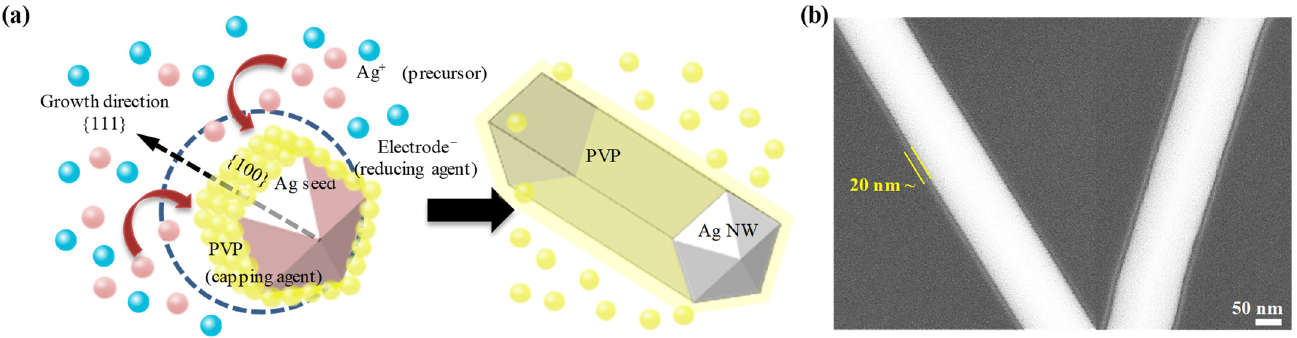
Figure 1. Synthesis of PVP-capped Ag NWs: ( a ) schematic of the Ag NW growth mechanism and ( b ) FE-SEM image of a PVP-capped Ag NW. ( b ) FE-SEM image of a PVP-capped Ag